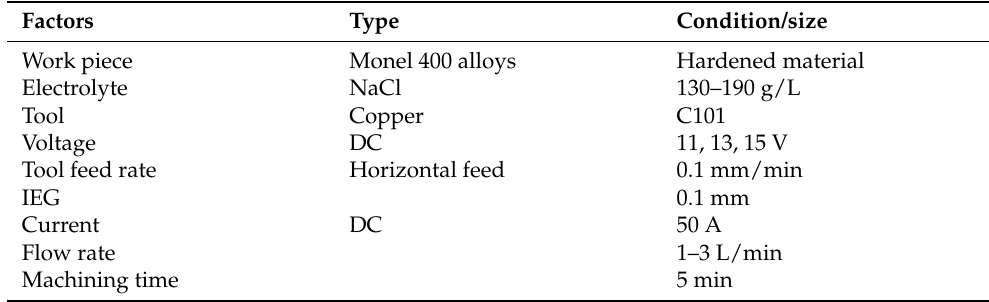
Figure 2. EECM experimental set-up. Table 2. Factors and conditions of ECM experiments.